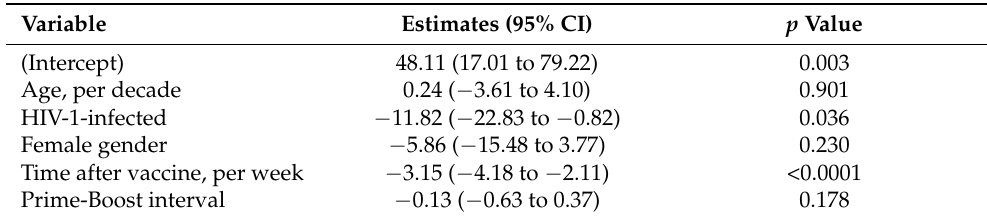
Table 6. Multivariate linear regression analysis of serum spike-specific neutralizing antibodies at a 1:101 dilution among the SARS-CoV-2 vaccinated